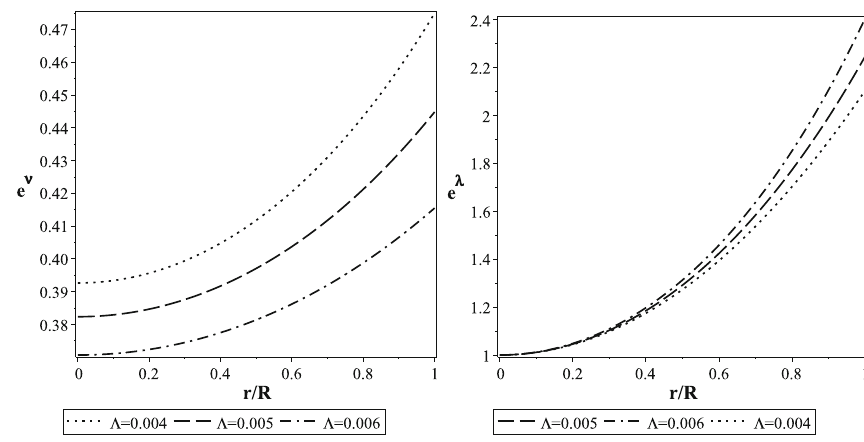
Fig. 5 Behavior of the metric potentials viz., e ν (left panel) and e λ (right panel) as a function of the fractional radial distance for the strange star candidate LMC X − 4 are shown